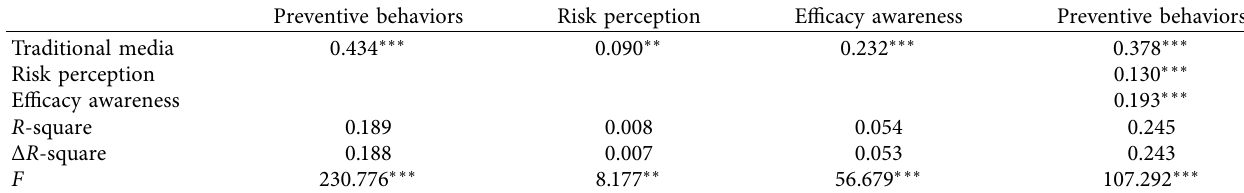
Table 12: Mediating efect test (traditional media information sources).